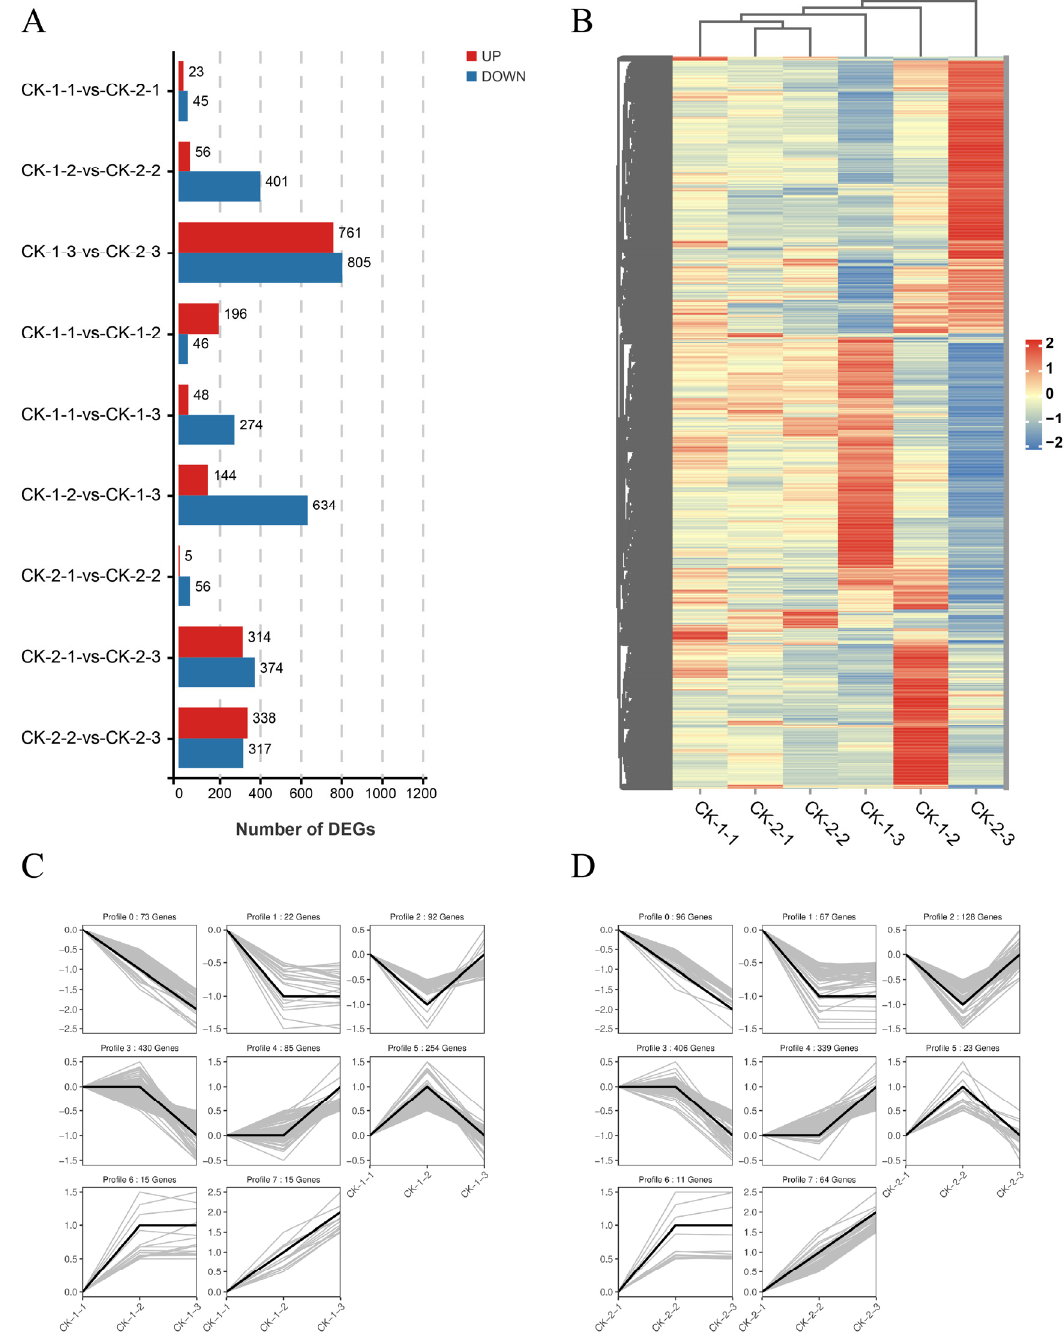
Figure 2. Overall analysis of differential gene expression between different treatment groups. ( A ): number of differentially expressed genes (DEGs) between different groups. ( A ) vs. ( B ) indicates the expression of ( B ) relative to ( A ). Red indicates up-regulation, blue indicates down-regulation. The screening conditions for differential genes were |log2FC| ≥ 1 and FDR < 0.05; B: Heat map of gene expression in different treatment groups. Each column represents one sample, and each row represents one gene. Gene expressions of rows were normalized using the z-score; the more red the color, the higher the gene expression, the more blue the color, the lower the gene expression; ( C ): The trend pattern of DEGs in the groups under − 10 °C stress (CK-1-1 vs. CK-1-2 vs. CK-1-3) with time. The black line represents the trend line, and the gray line represents each gene; ( D ): The trend pattern of DEGs in the groups under − 16 °C stress (CK-2-1 vs. CK-2-2 vs. CK-2-3) over time.